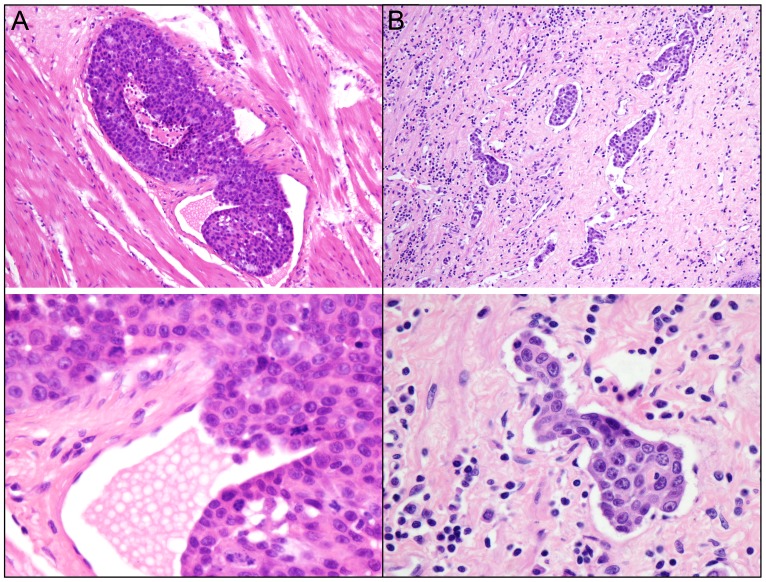
The patterns of vascular invasion in ESCC.A: Tumor cells were encroaching into the blood vessel wall (upper panel, ×100; lower panel, ×400). B: Tumor emboli were found in vascular spaces (upper panel, ×100; lower panel, ×400).